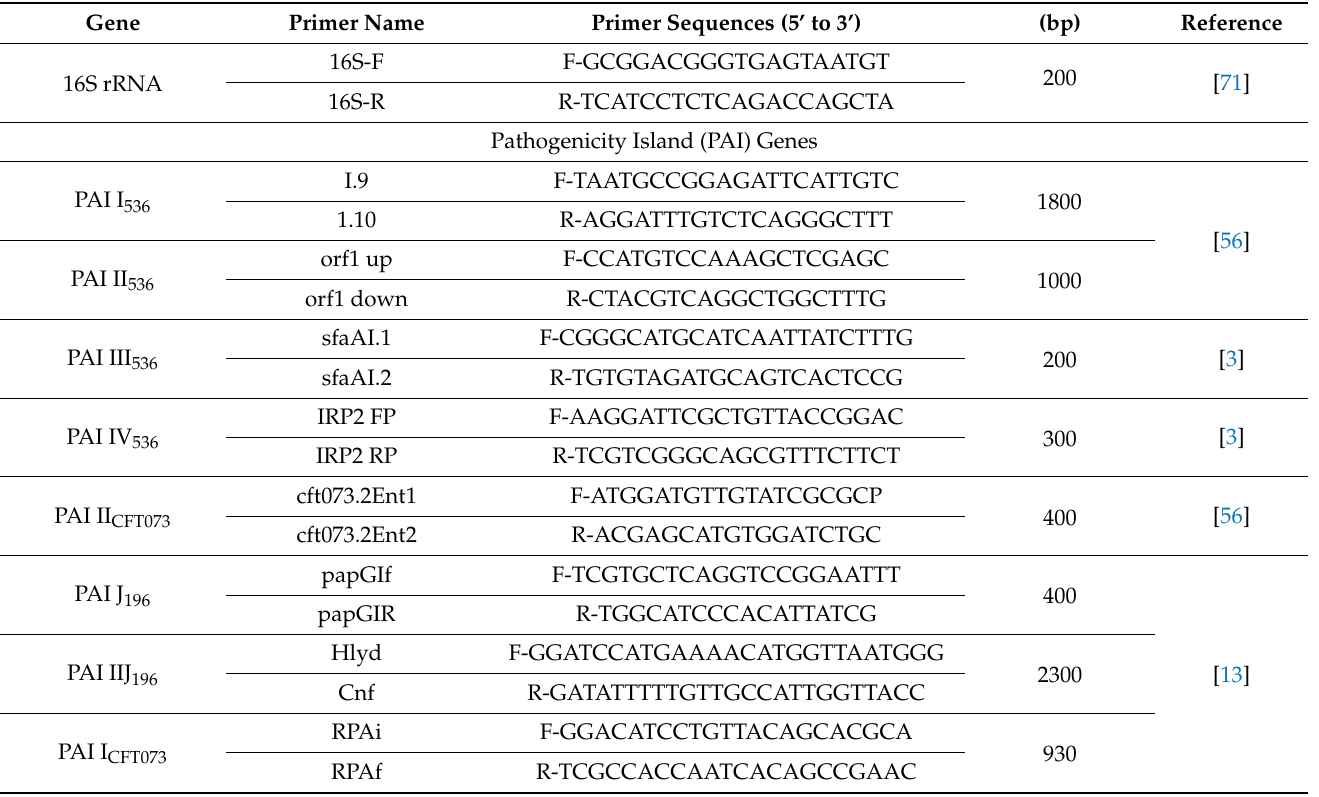
Table 7. List of oligonucleotide primers used in the present